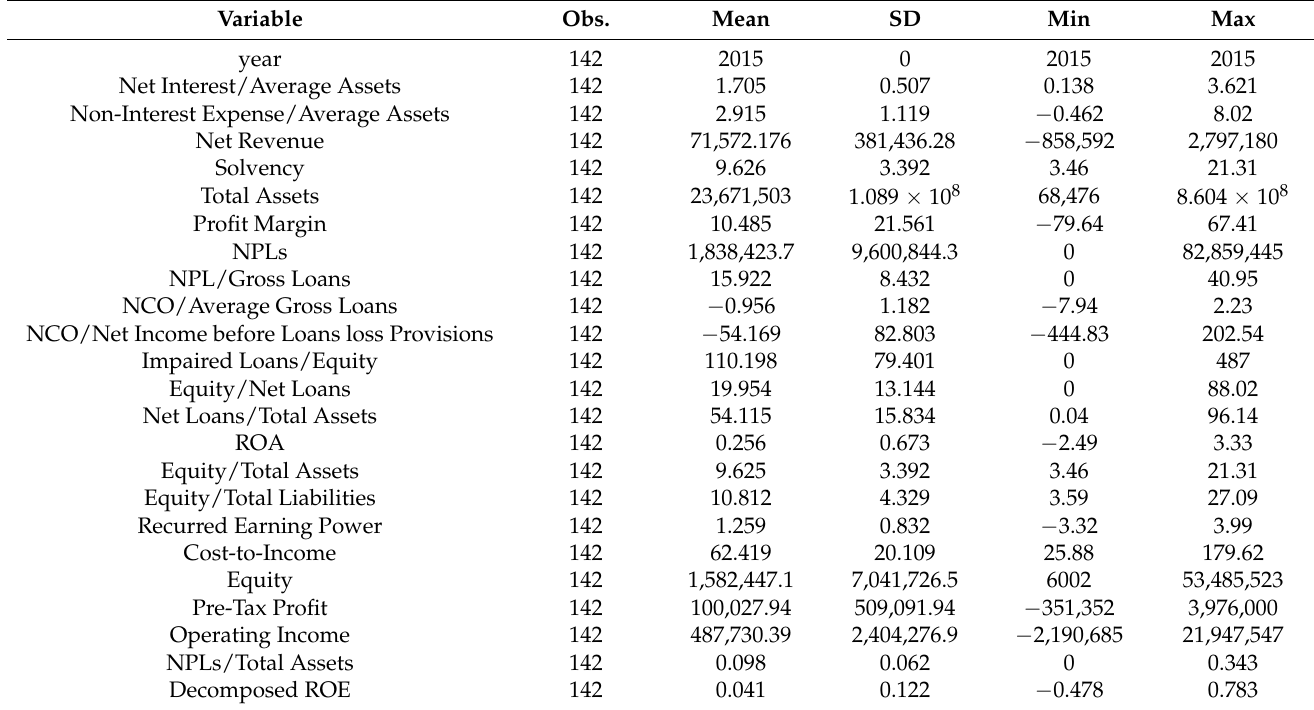
Table A5. Descriptive statistics for the 142 Italian banks for the year 2015.